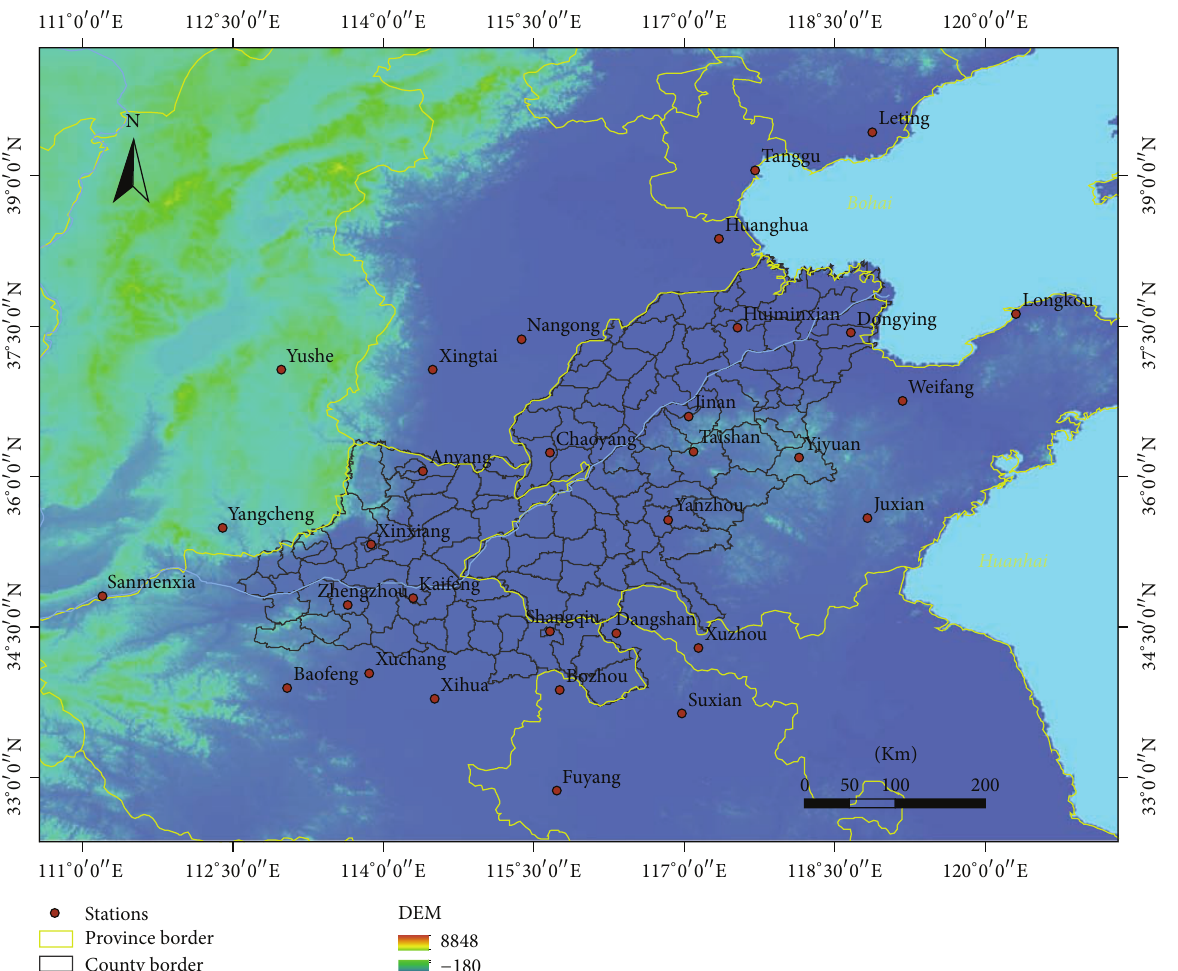
Figure 1: The Lower Yellow River Region and distribution of meteorological